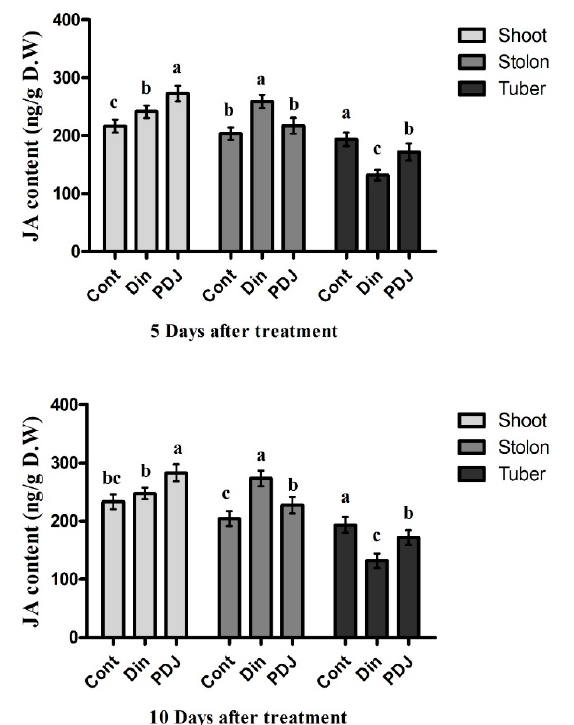
Fig. 6: Total JA contents by site per each treatment (Cont; Control, Din; Diniconazole, PDJ; Prohydrojasmon). The differences between mean values were determined using a DMRT at P < 0.05. The results were graphically presented using GraphPad Prism (version 5.0, San Diego, CA, USA). The SAS 9.1 was used for DMRT